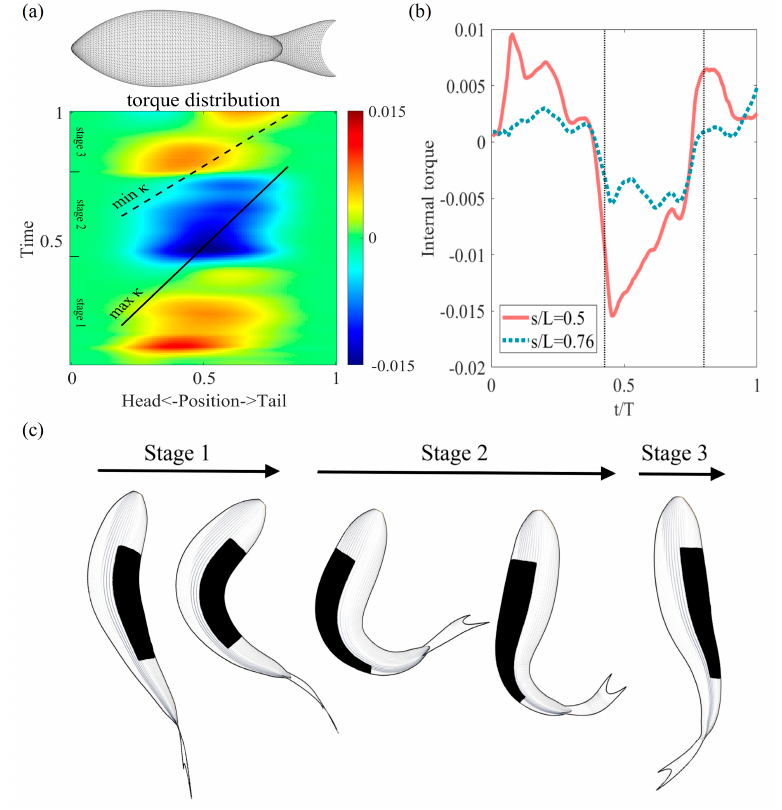
Figure 9. ( a ) Spatiotemporal distribution of the internal torque. The solid and dashed lines indicate the maximum and minimum curvatures, respectively. ( b ) The torque variation with time on middle body (s/L = 0.5) and peduncle (s/L = 0.76). ( c ) Schematic of muscle actuation.